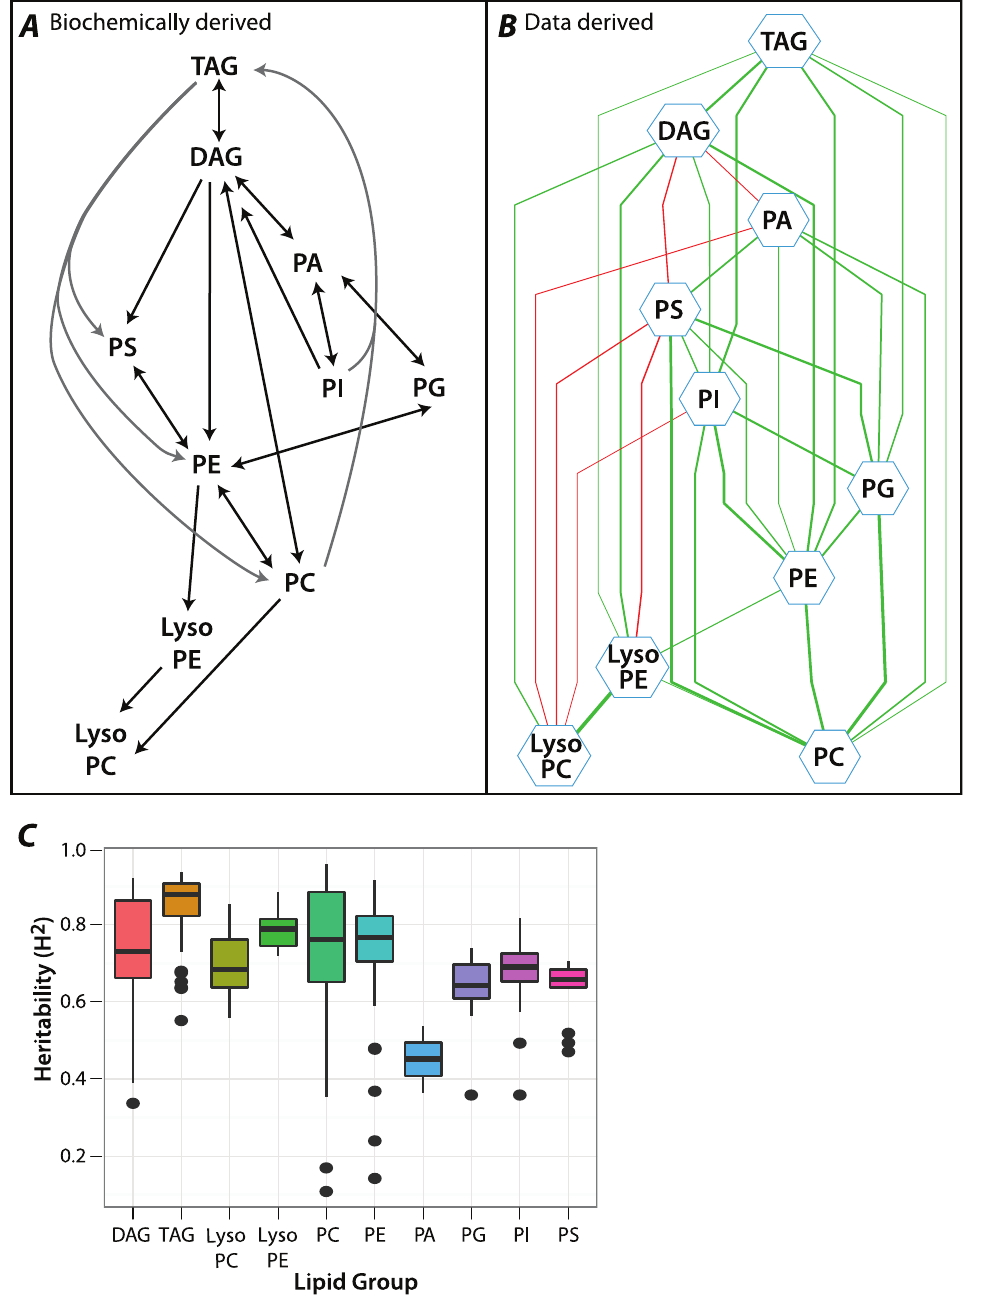
Figure 1. Lipid network conforms with known metabolism and has high heritability. A: Metabolic network for the relations among lipid classes, as derived from the literature [23]. B: Network constructed from our lipid composition data using Cytoscape. All pairs of lipid classes with PCC . 0.1 or PCC ,2 0.1 are connected in the network. A positive correlation between two lipid classes is represented by a green edge, while a negative correlation is represented by a red edge. The thickness of the edges is proportional to the magnitude of PCC between the lipid classes. C: Broad sense heritability (H 2 ) for each measured lipid species grouped by lipid class. Circles are outliers and represent specific lipid species.